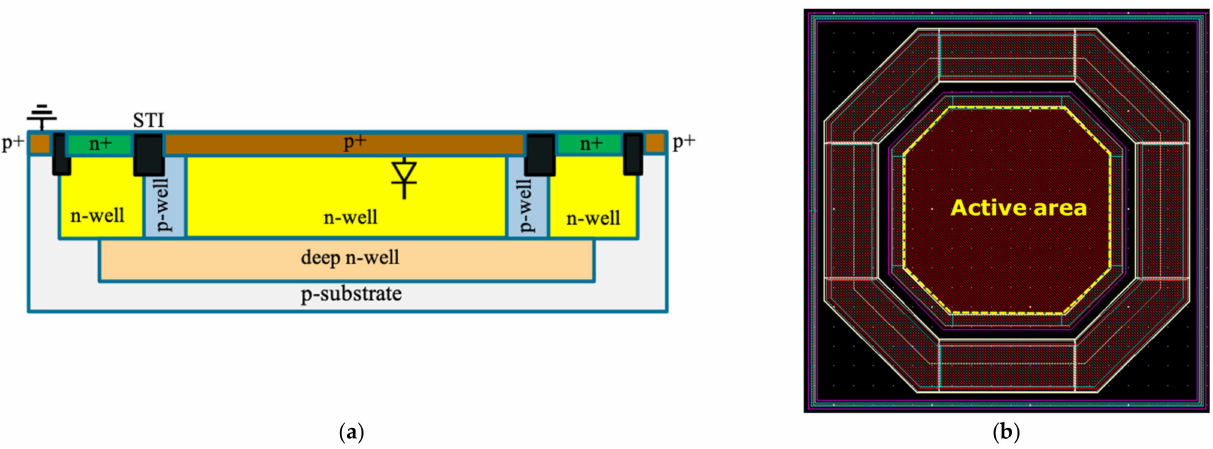
Figure 3. ( a ) Cross-sectional and ( b ) top views of the SPAD